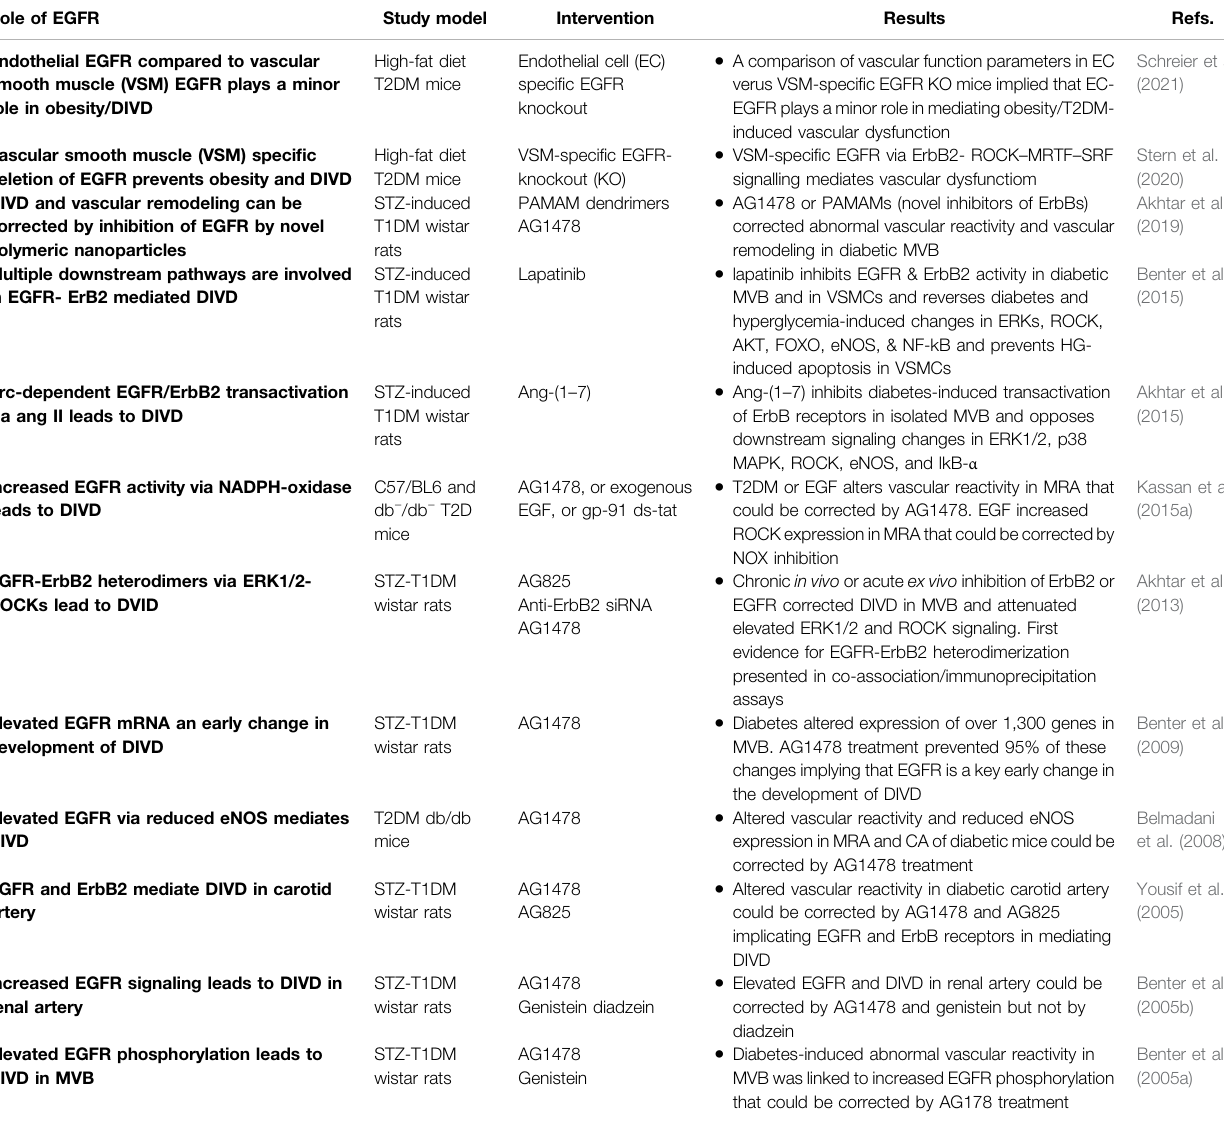
TABLE 3 | A summary of selected studies implicating EGFR signaling in diabetes-induced vascular dysfunction. Role of